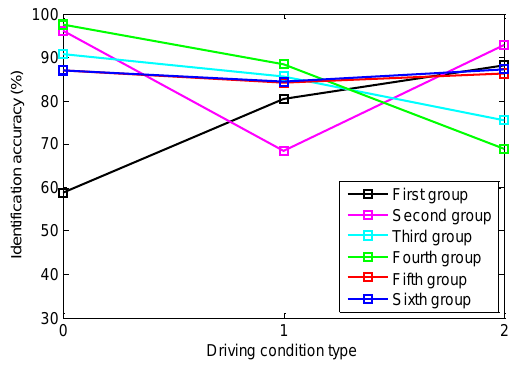
Figure 13. Accuracy comparison of six groups of characteristic parameters.